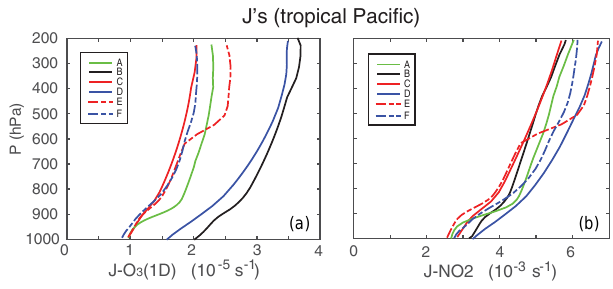
Figure 4. Modeled 24h average J -values for O 3 + hv = >O( 1 D ) + O 2 ( a , s − 1 ) and NO 2 + hv = >NO + O ( b , s − 1 ) for the tropical Pacific (20 ◦ S–20 ◦ N, 150–210 ◦ E). See Fig. 3 and Table 1 for model